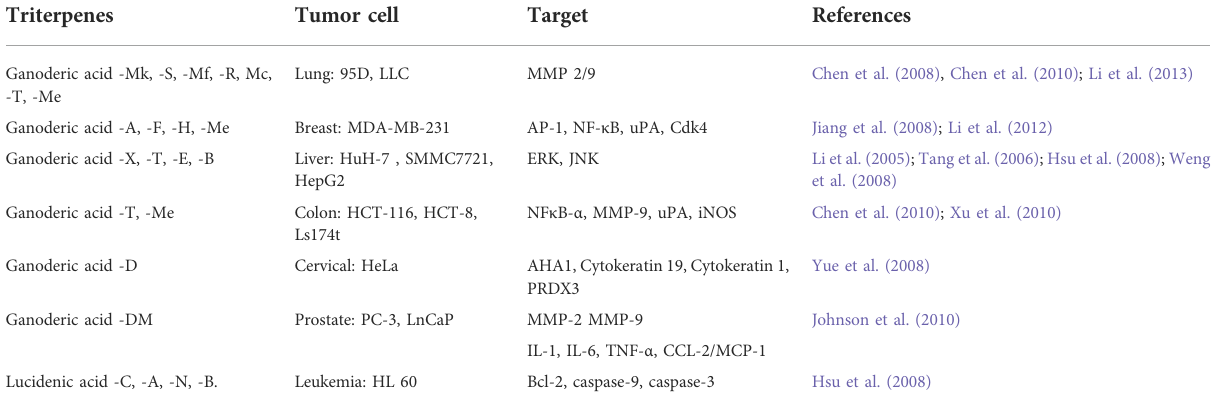
TABLE 1 Triterpenoids with antitumor action on different cell